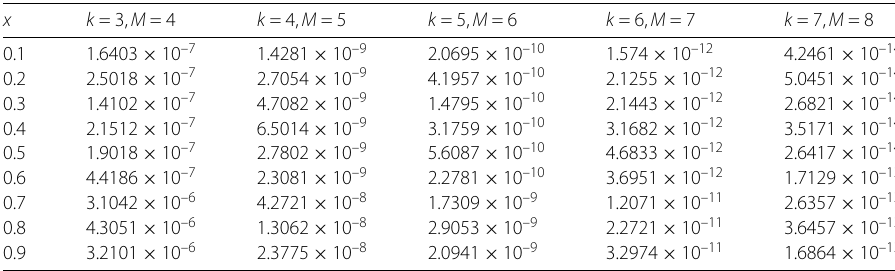
Table 1 The absolute error for Example 7.1 for different estimations of k , M at α =